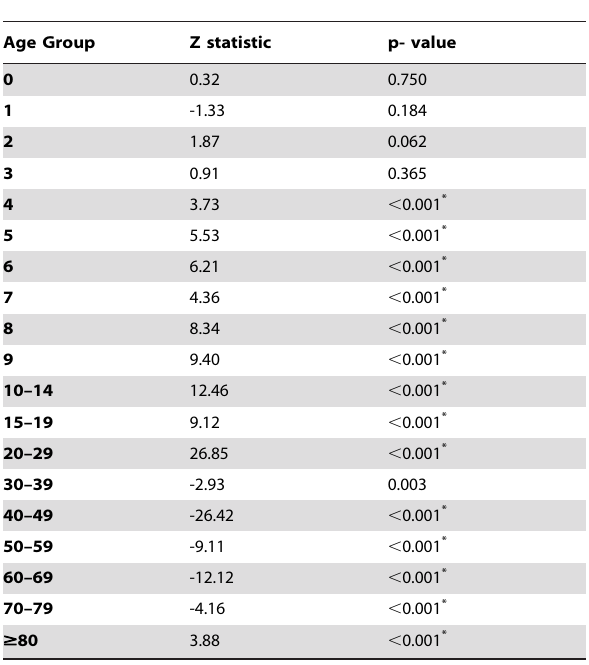
Table 3. Comparison of the M/F ratios by age for 2009 pdmH1N1 with that for 2005 seasonal influenza.